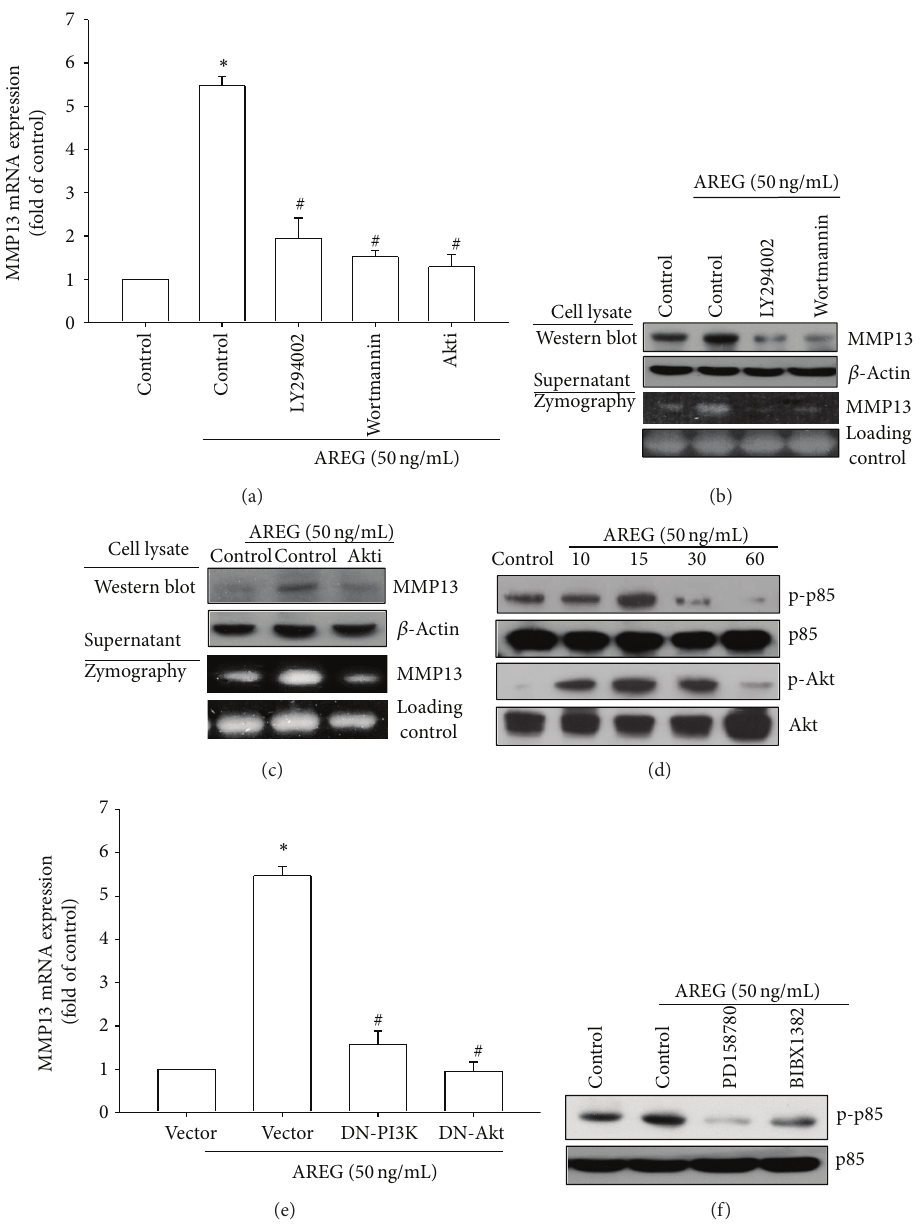
Figure 3: PI3K/Akt is involved in AREG-mediated MMP-13 production in synovial fibroblasts . (a) OASFs were pretreated for 30 min with PI3Kinhibitors(LY294002(5 𝜇 M)andWortmannin(0.5 𝜇 M))andAktinhibitor(Akti(5 𝜇 M))for30minfollowedbystimulationwithAREG for 24 h, and MMP-13 expression was examined by qPCR. ((b) and (c)) OASFs were pretreated for 30 min with PI3K inhibitors (LY294002 (5 𝜇 M) and Wortmannin (0.5 𝜇 M)) and Akt inhibitor (Akti (5 𝜇 M)) for 30 min followed by stimulation with AREG for 24 h; MMP-13 protein levels in cell lysates were determined by Western blot analysis. MMP-13 enzymatic activity in cell lysates and supernatants was measured using zymography. (d) OASFs were incubated with AREG for indicated time intervals, and p85 and Akt phosphorylation was examined by Western blot. (e) OASFs were transfected for 24 h with PI3K and Akt mutant followed by stimulation with AREG for 24 h, and MMP-13 expression was examined by qPCR. (f) OASFs were pretreated for 30 min with PD158780 (1 𝜇 M) and BIBX1382 (1 𝜇 M) followed by stimulation with AREG for 15min; MMP-13 protein levels in cell lysates were determined by Western blot analysis. Results are expressed as the mean ± SEM (𝑛 = 3) . ∗ 𝑃 < 0.05 compared with control; # 𝑃 < 0.05 compared with AREG-treated